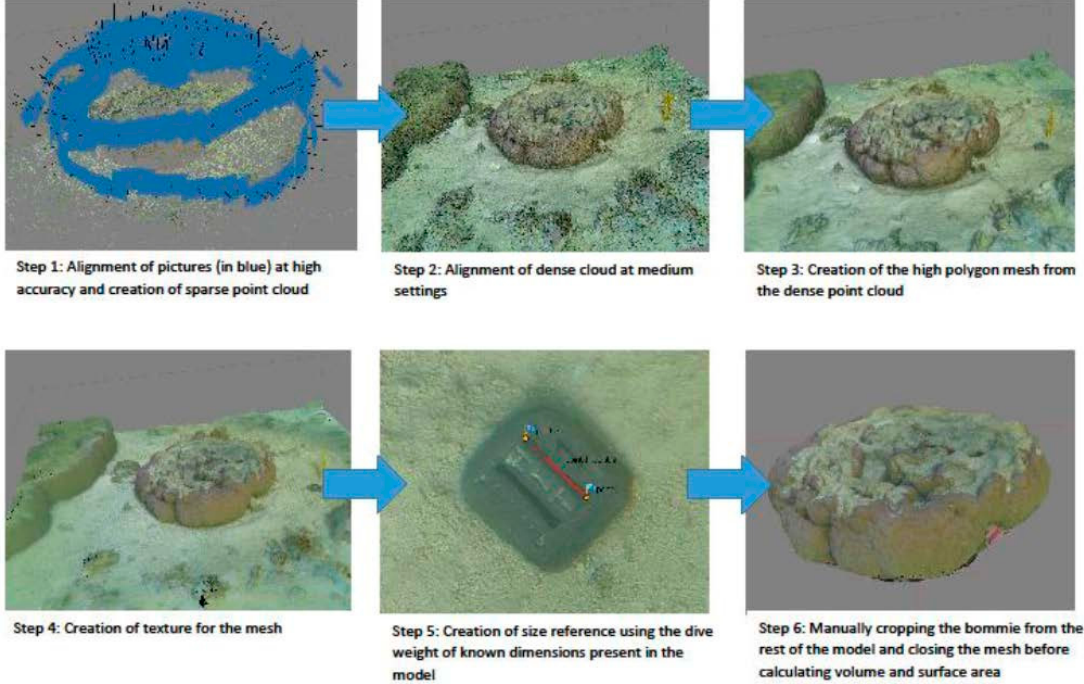
Figure 1. Simplified measurement pipeline with Agisoft Photoscan Professional, from image alignment to volume and surface area measurements. The model can be viewed and manipulated online at https://skfb.ly/6n6Hy.